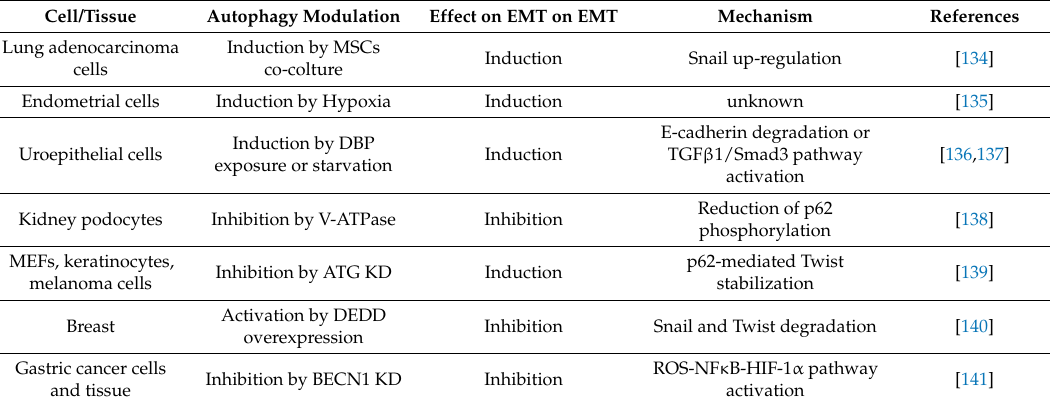
Table 2. Autophagy and